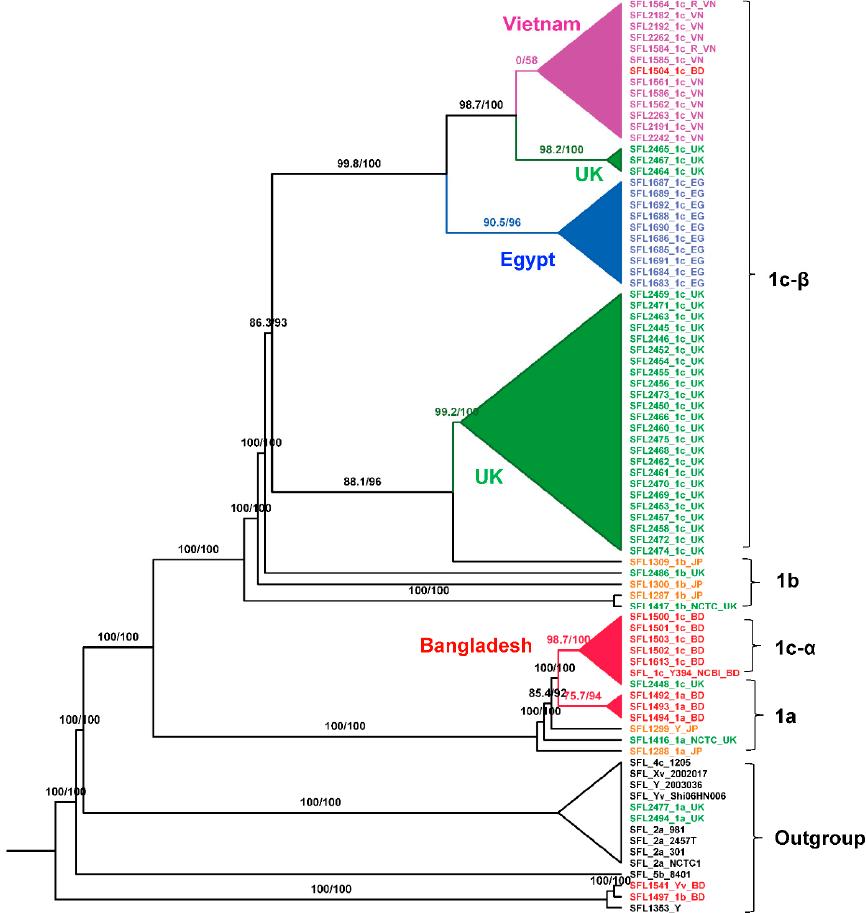
Figure 4. Maximum-Likelihood (ML) phylogeny for S. flexneri isolates. The phylogeny was based on the alignment of concatenated core genes with the recombination region removed. The ML tree was reconstructed using the general time-reversible model with a proportion of invariable sites (GTR + F + I) as the best-fit model. The analysis showed two distinct 1c lineages: 1c- α is specific to Bangladeshi isolates that was likely evolved from 1a strains; 1c- β is specific to the isolates from the UK, Egypt, and Vietnam. The labels indicate the strain number followed by the serotype and the country of isolation. The isolates from different sources were color-coded: red (Bangladesh), blue (Egypt), orange (Japan), green (UK), purple (Vietnam), and black (GenBank). The branch annotations are the Shimodaira-Hasegawa approximate likelihood ratio supports and the bootstrap supports (1000 pseudoreplicates). The branch lengths are not drawn to scale.